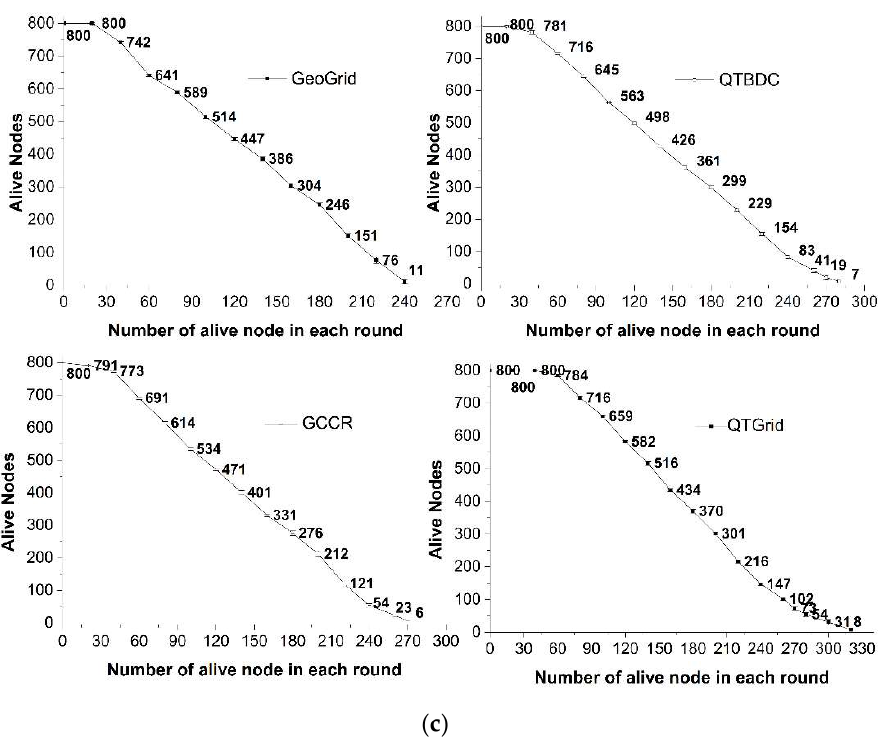
Figure 9. The comparison of the number of surviving nodes. ( a ) Network with 200 nodes; ( b ) network with 400 nodes; ( c ) network with 800 nodes.